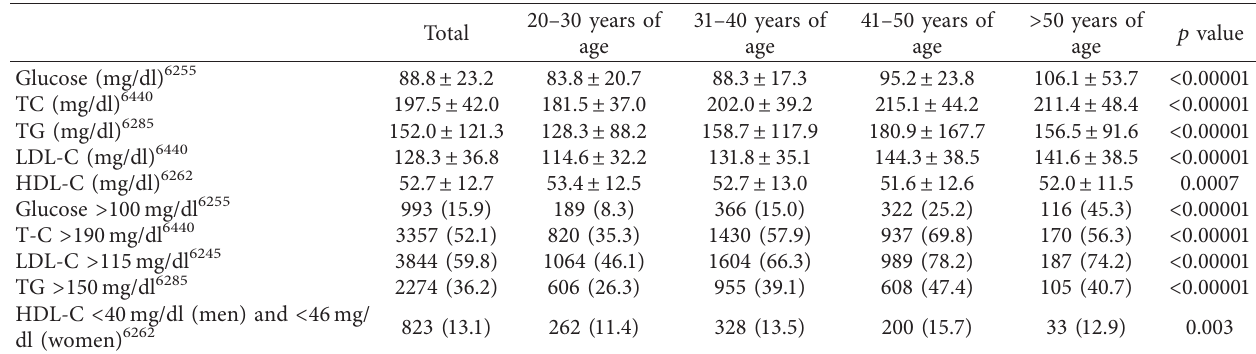
Table 3: The results of laboratory tests.